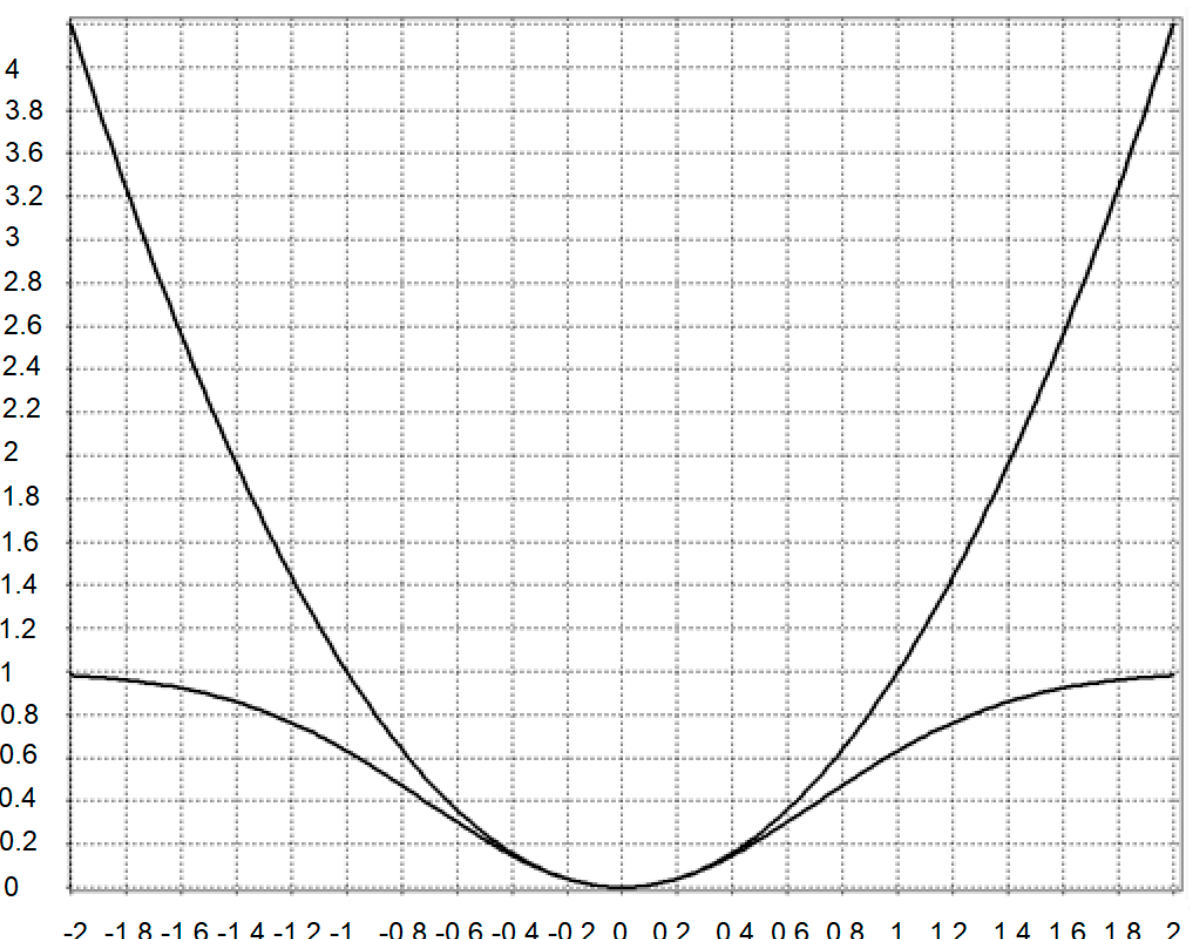
Figure 1. Comparative representation of the quadratic distance function and the distance function constructed under the assumption that the error has a Gaussian probability distribution.